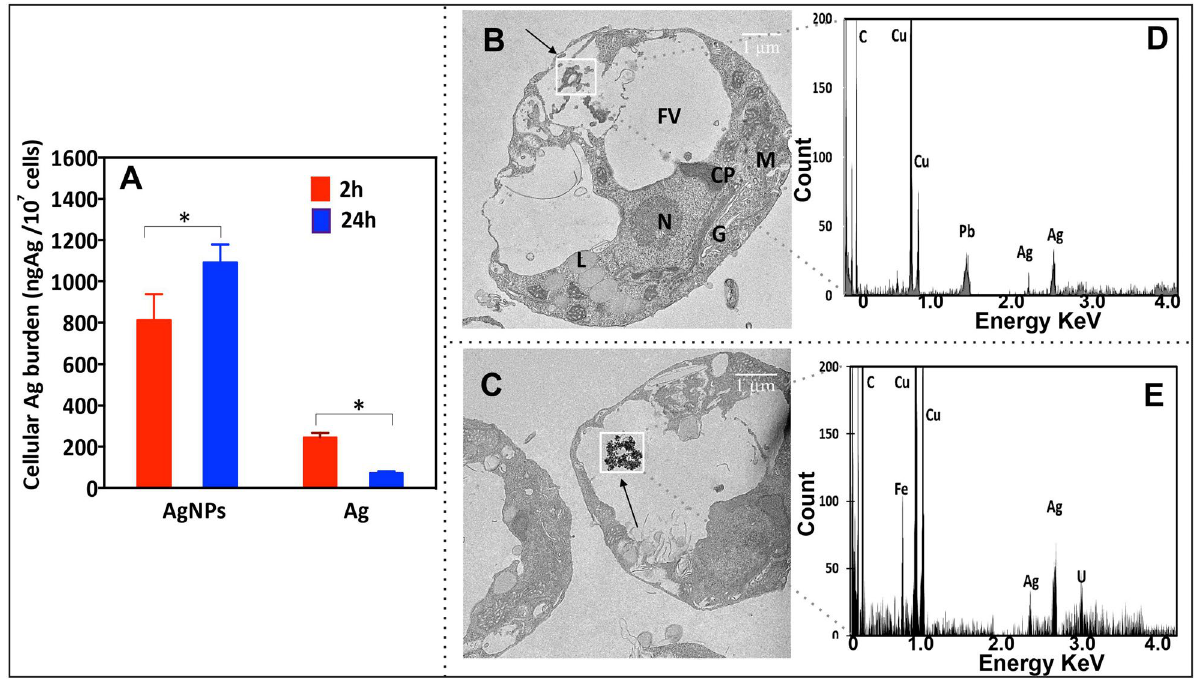
Figure 2. ( A ) Ag cellular burden of P. malhamensis exposed to 1.0 mg L −1 AgNPs or 40.7 μg L −1 AgNO 3 during 2 h and 24 h. The results are presented as ng of cellular Ag per 1 × 10 7 cells. Asterisk indicates a significant difference between treatments obtained by two-way analysis of variance (ANOVA) followed by a Sidak’s multiple comparisons test ( p < 0.05); ( B , C ) TEM images of P. malhamensis : treated with 1 mg L −1 AgNPs for 2 h ( B ) and for 24 h ( C ); ( D , E ) energy dispersive X-ray (EDX) spectra correspond to the interest area from C ( D ) and D ( E ). Letters on ( B ) denote cell organelles: G Golgi body, M mitochondrion, N nucleus, FV food vacuole, L lipid drops, CP chloroplast. * p < 0.05, ** p < 0.01, *** p <